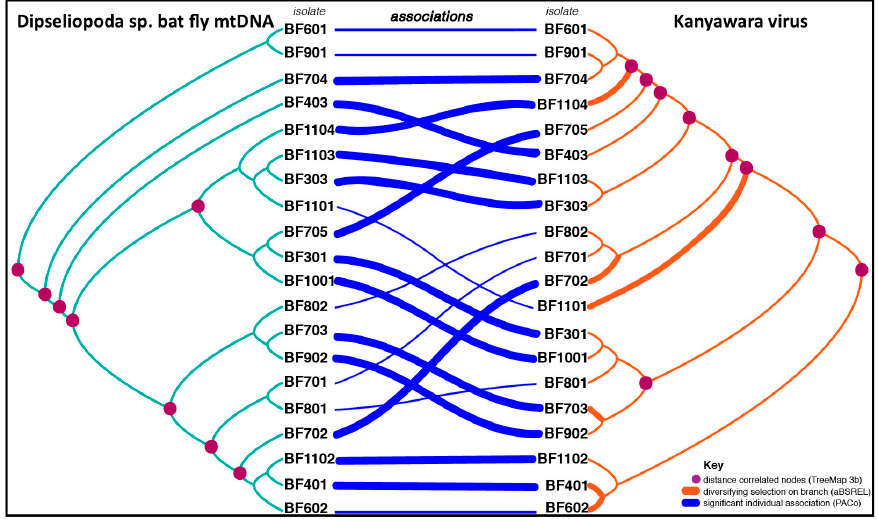
Figure 2. Selection and diversity within KYAV-like viruses and viruses of neighbor taxa. ( A ) Sliding window plot (100-aa window, 20-aa step) of dN / dS across the genome of 20 KYAV-like viruses from Bundibugyo District, Uganda. Genome-wide dN / dS < 1, indicating stabilizing selection predominates, but this constraint is relaxed for portions of P, M, and L. ( B ) Average pairwise distances of nucleotide (NT) and amino acid (AA) sequences for each virus gene within the KYAV isolates, between KYAV isolates and BUGV, between KYAV isolates and Mount Elgon bat virus (MEBV), and between BUGV and MEBV are represented by a heat map. For KYAV-like viruses in the population, average pairwise distances varied across genes, and were high for a single population (Avg NT dist: N = 5.12%, P = 9.74%, M = 7.76%, G = 7.34%, L = 7.00%; Avg AA dist: N = 1.30%, P = 6.03%, M = 2.86%, G = 0.77%, L = 4.00%).